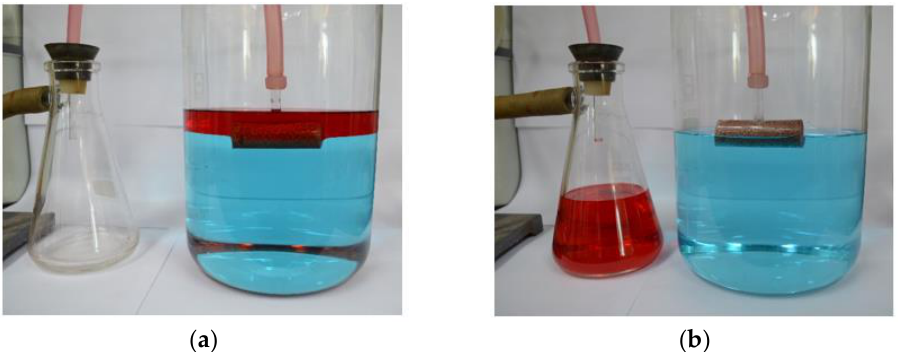
Figure 8. Optical pictures of the self-primed oil pump taken ( a ) before and ( a ) after its operation. The 385 mL of n -hexane (dyed red) on the surface of water (dyed blue) was selectively transferred to the collecting flask by a vacuum aspirator during an operation time of 120 s.